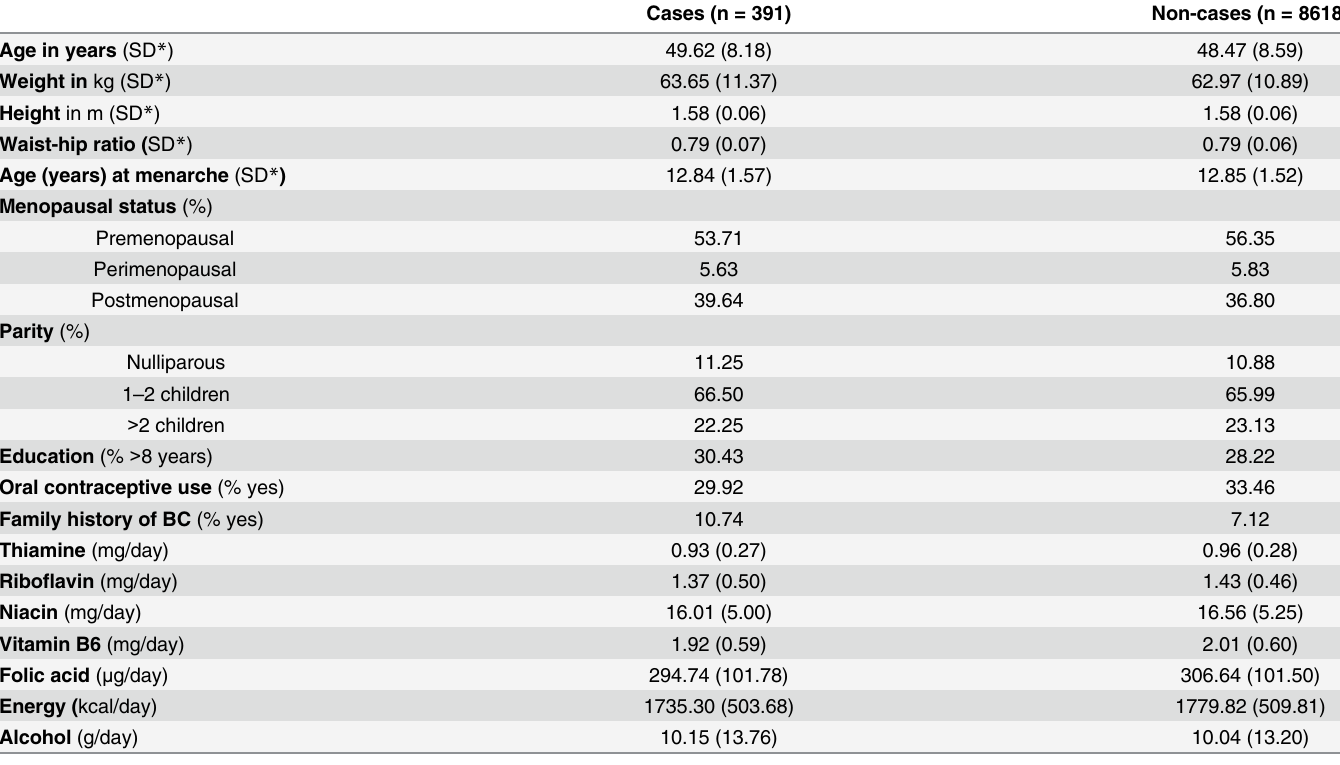
Table 1. Baseline distribution of nutrients and factors influencing breast cancer risk by disease status in ORDET